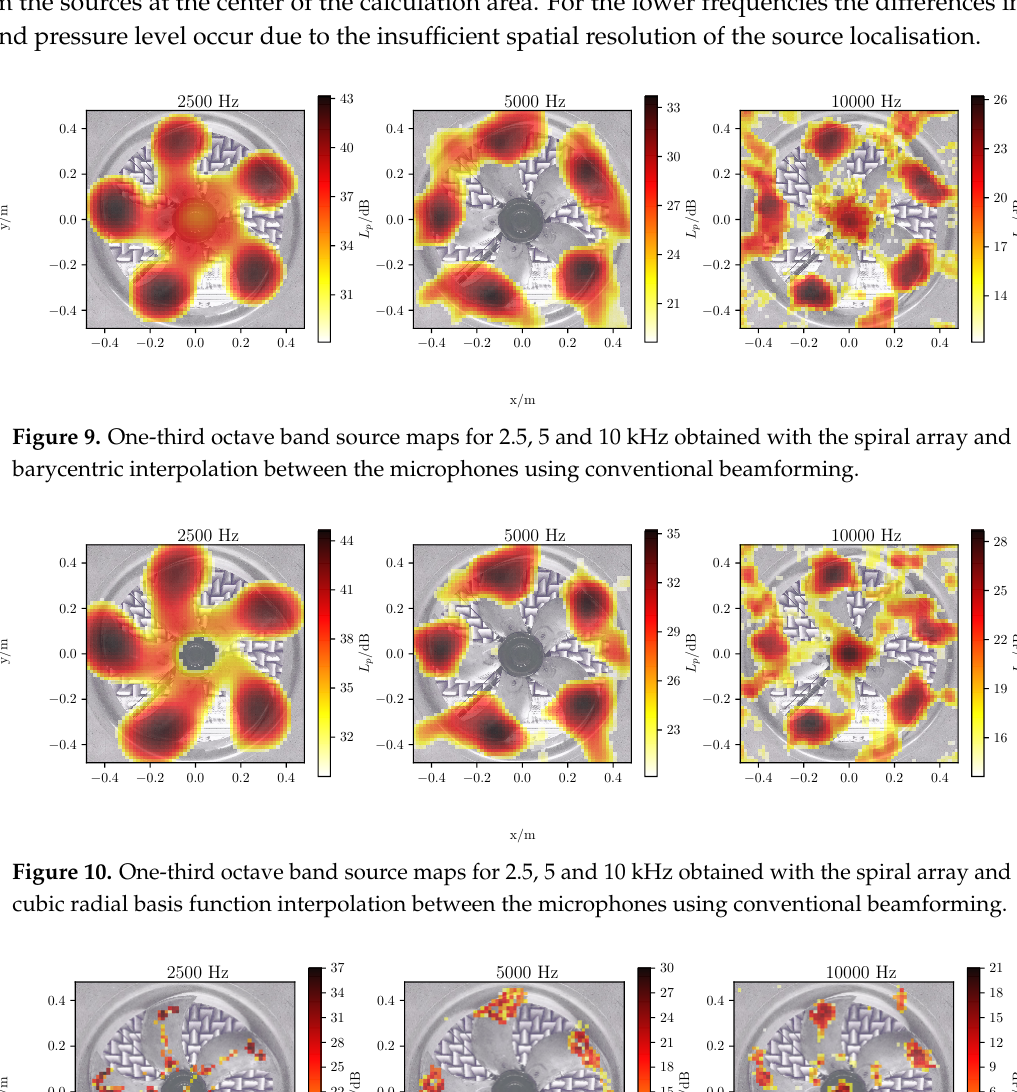
from the sources at the center of the calculation area. For the lower frequencies the differences in the sound pressure level occur due to the insufficient spatial resolution of the source localisation.